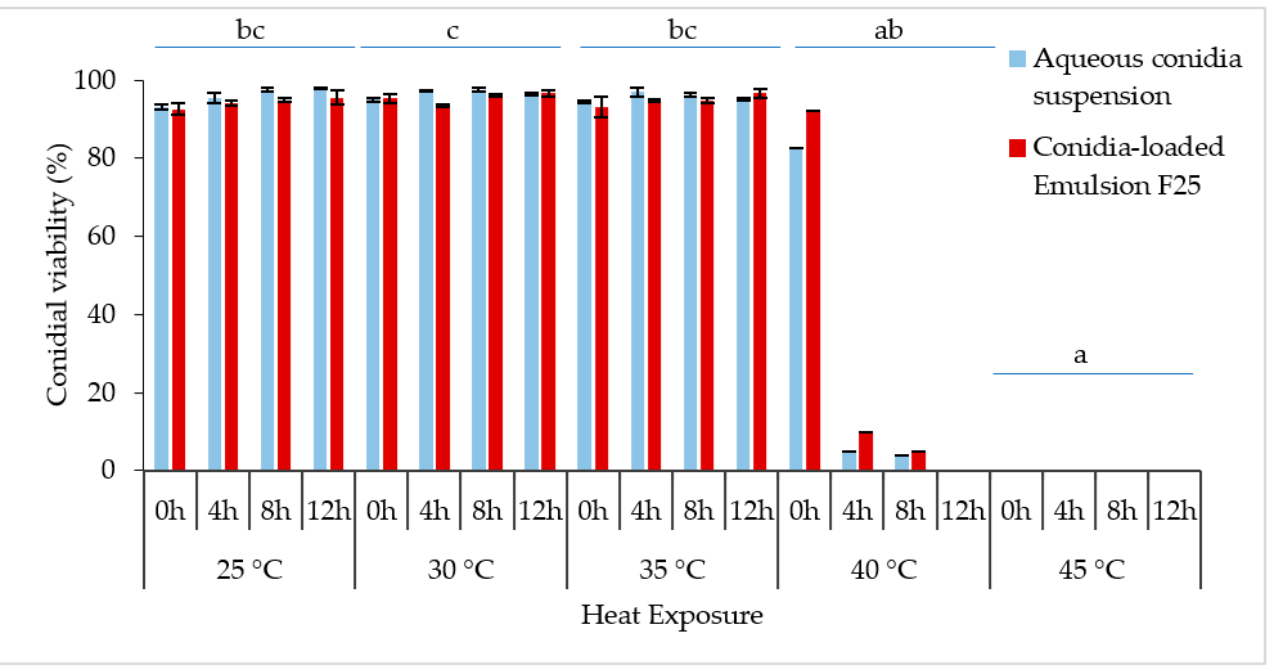
Figure 9. The conidial germination rate (%) of M. anisopliae at different temperatures (25 °C, 30 °C, 35 °C, 40 °C, and 45 °C) ( n = 40). Bars represent mean ± standard deviation. No significant difference was detected between aqueous suspension and emulsion, thus temperature treatments followed by different letters denote significant difference at p < 0.05. (Kruskal–Wallis, α = 0.05); significant values were adjusted by Bonferroni correction by multiple